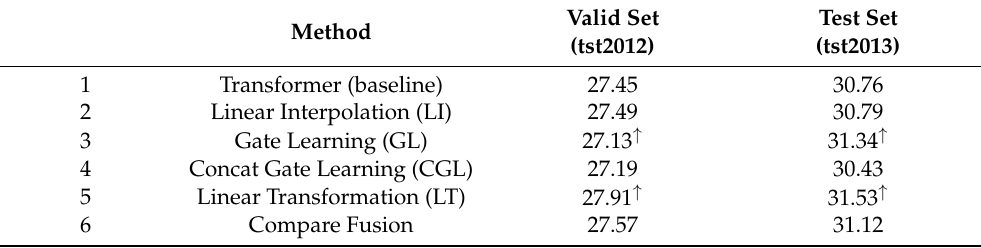
Table 3. BLEU values for different interpolation methods on the IWSLT15 (En–Vi) task.